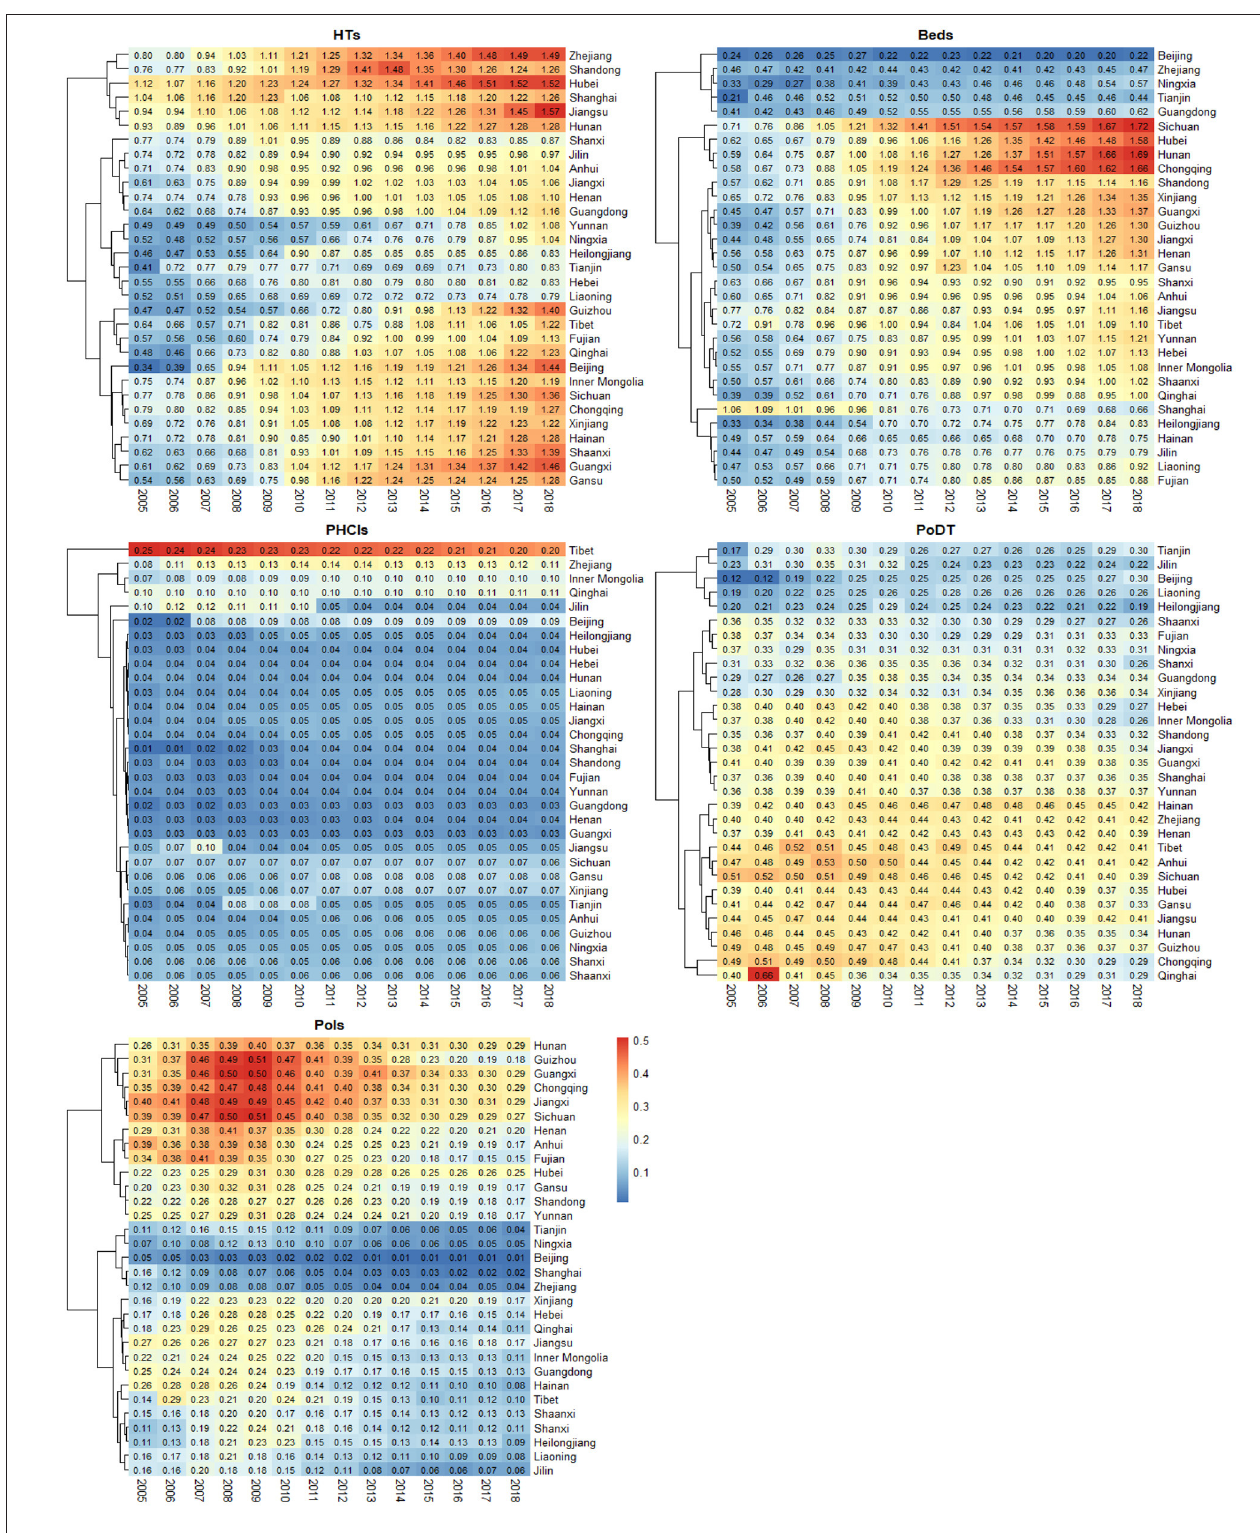
FIGURE 2 | Provincial comparison of input–output indicators in 2005–2018.